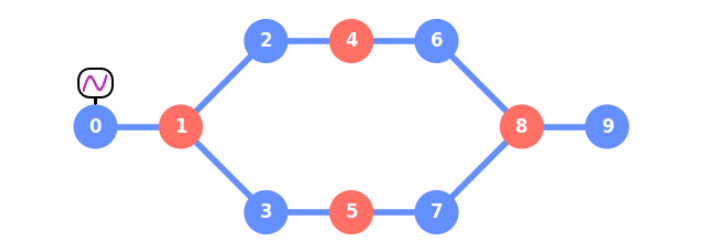
Figure 6: A plaquette with single edge qubits, containing ten qubits in total, alter- nating in frequency as depicted by their color. The bonds indicate qubits interacting with with their nearest neighbors by a ‘flip-flop’ (XY) interaction term as in Eq. (21). Qubit 0 is being driven periodically as in Eq.